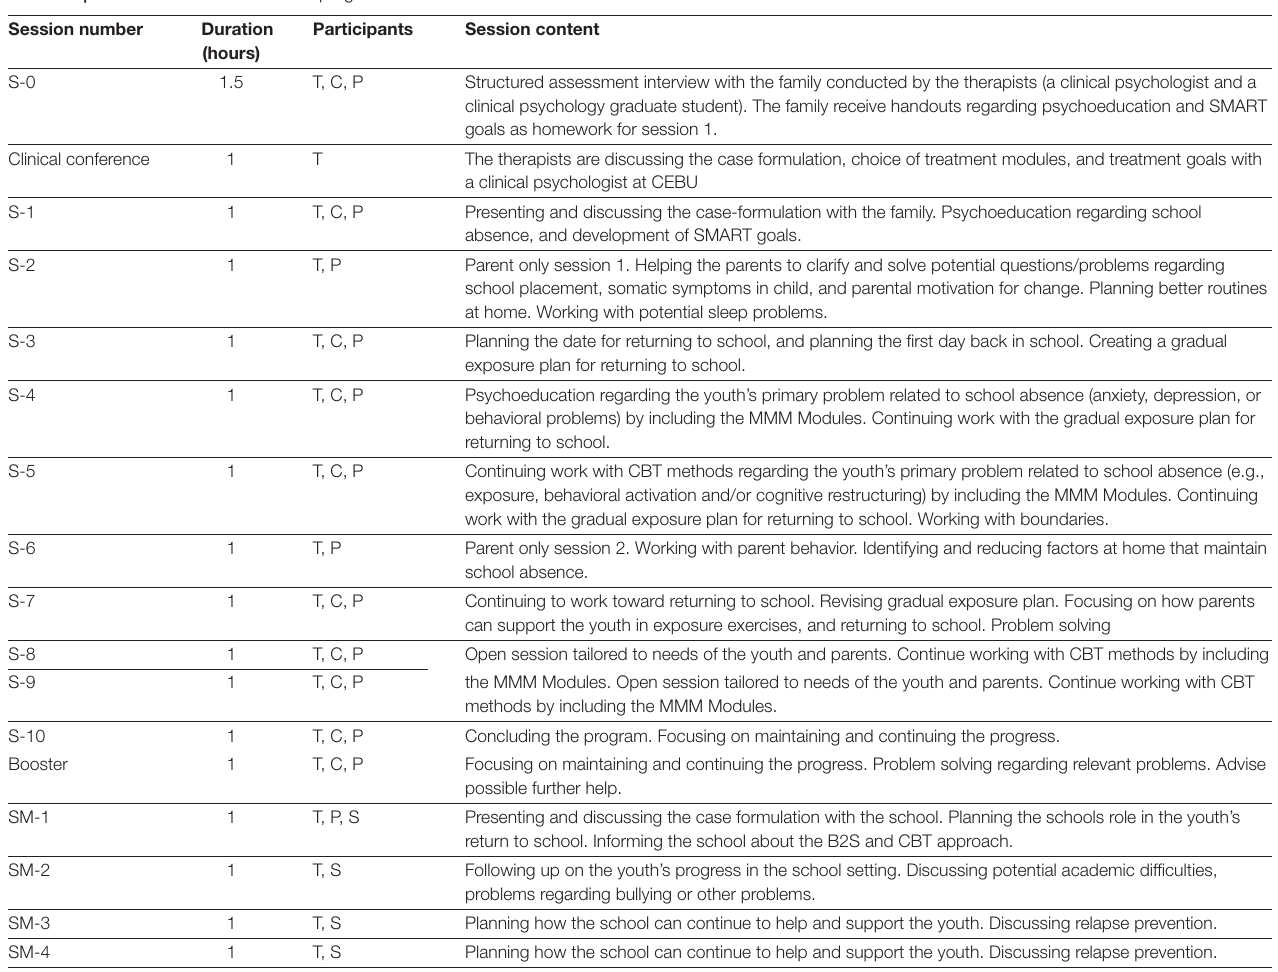
TABLE 1 | Overview of the Back2School